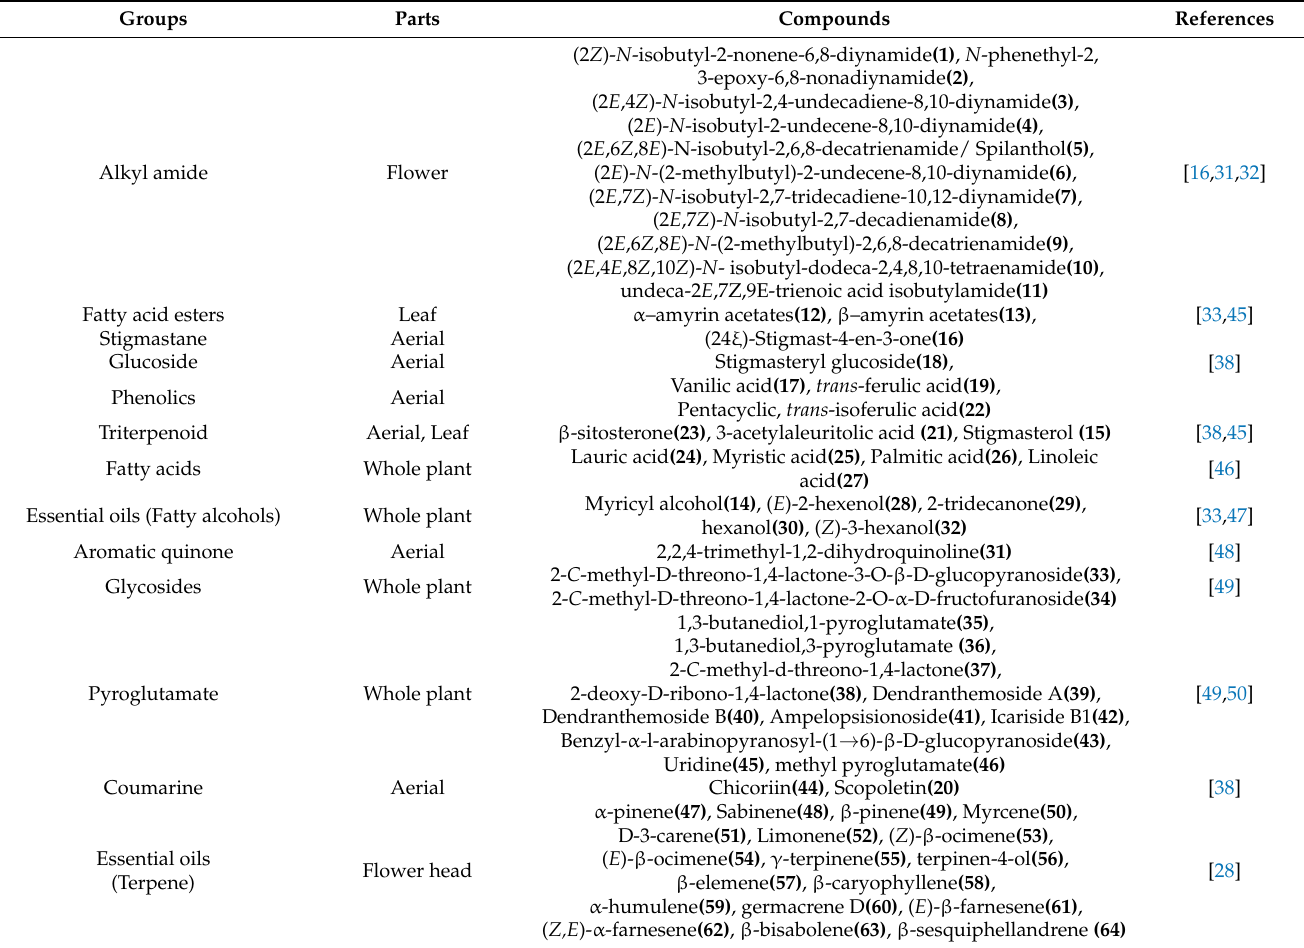
Table 2. Phytochemicals in S.